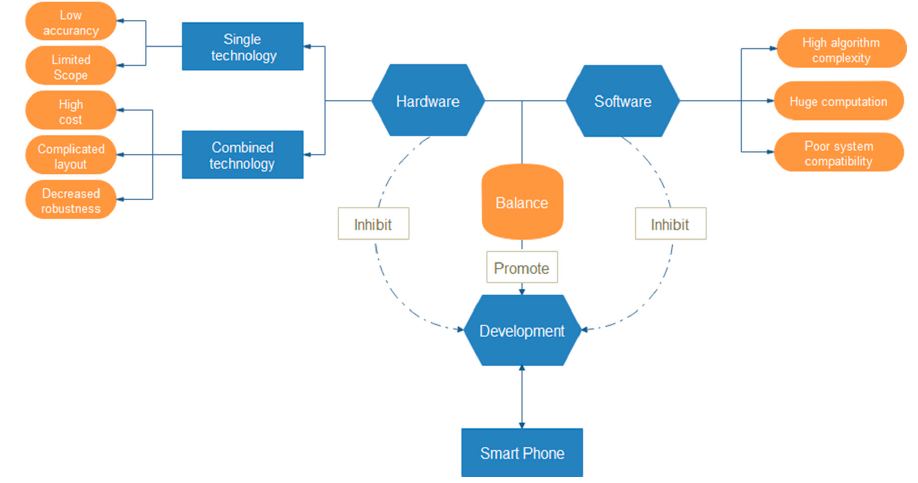
Figure 5. The dilemma of development of sensor-based technology.